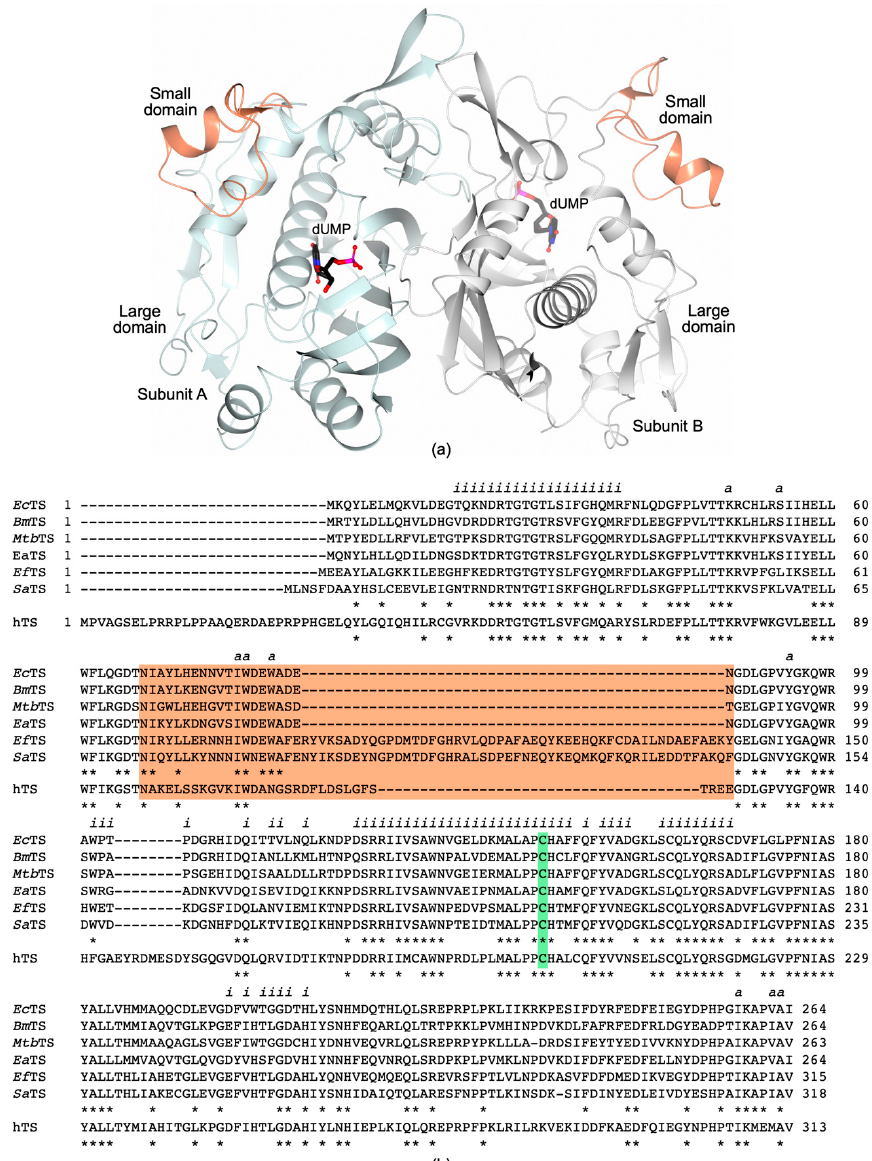
Figure 2. ( a ) Cartoon representation of the TS homodimer ( Mtb TS, PDB id 3QJ7, unpublished research). The LD of Subunits A and B are colored light cyan and white, respectively. The SD (residues 67–87, in Mtb TS) is colored coral in both subunits. The position of the active site is indicated by the presence of the substrate dUMP (in sticks, black carbons). ( b ) Sequence alignment of TSs from pathogenic bacteria and the human enzyme (hTS). Enterococcus faecalis TS ( Ef TS, UniProtKB: Q834R3), Staphylococcus aureus TS ( Sa TS, UniProtKB: P67046), Brucella melitensis TS ( Bm TS, UniProtKB: